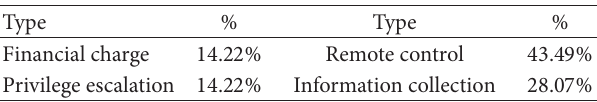
Table 3: Distribution of malware Apps in the official market accord- ing to their